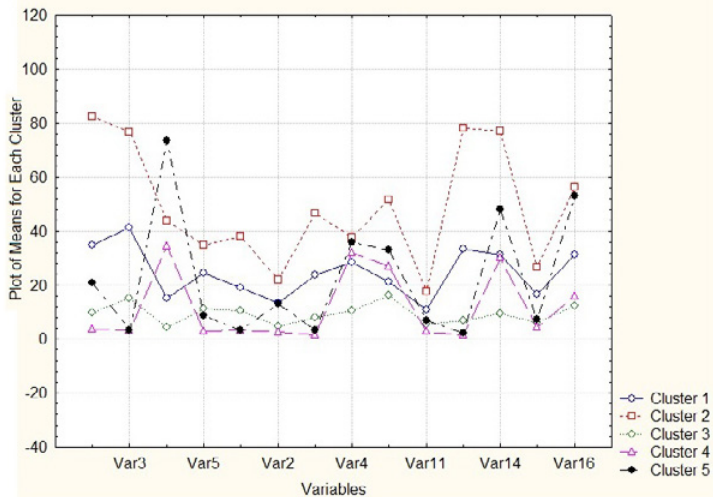
Fig. 7: Results of cluster analysis of energy efficiency of KNUTD buildings (Listing of STATISTICA10 program) by the level of energy consumption and